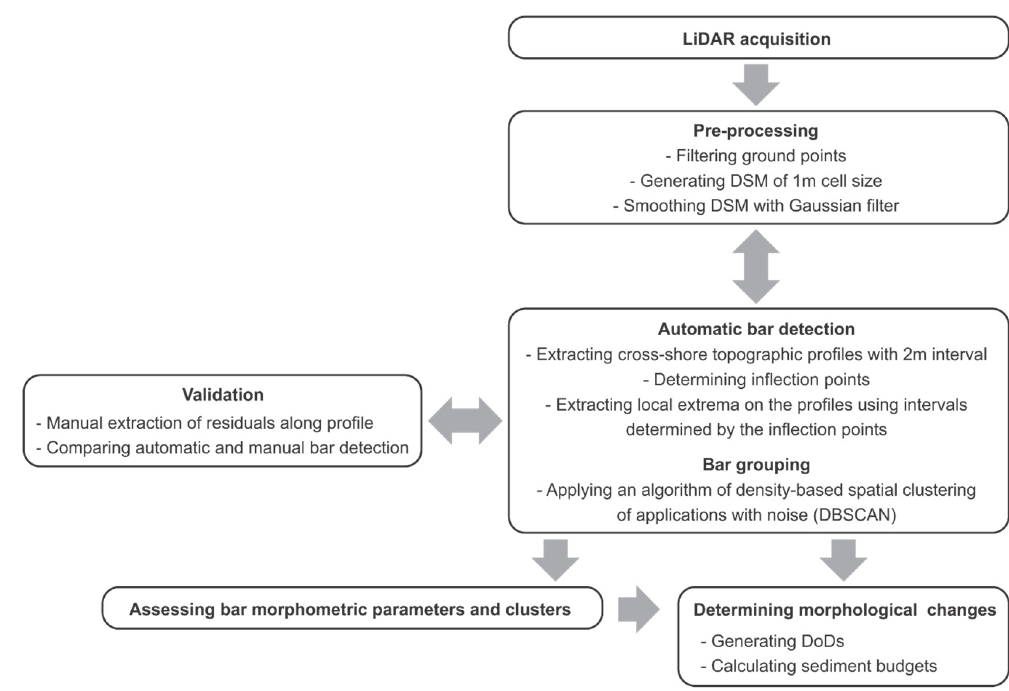
Figure 2. Workflow of PROTECT toolbox and analyses.